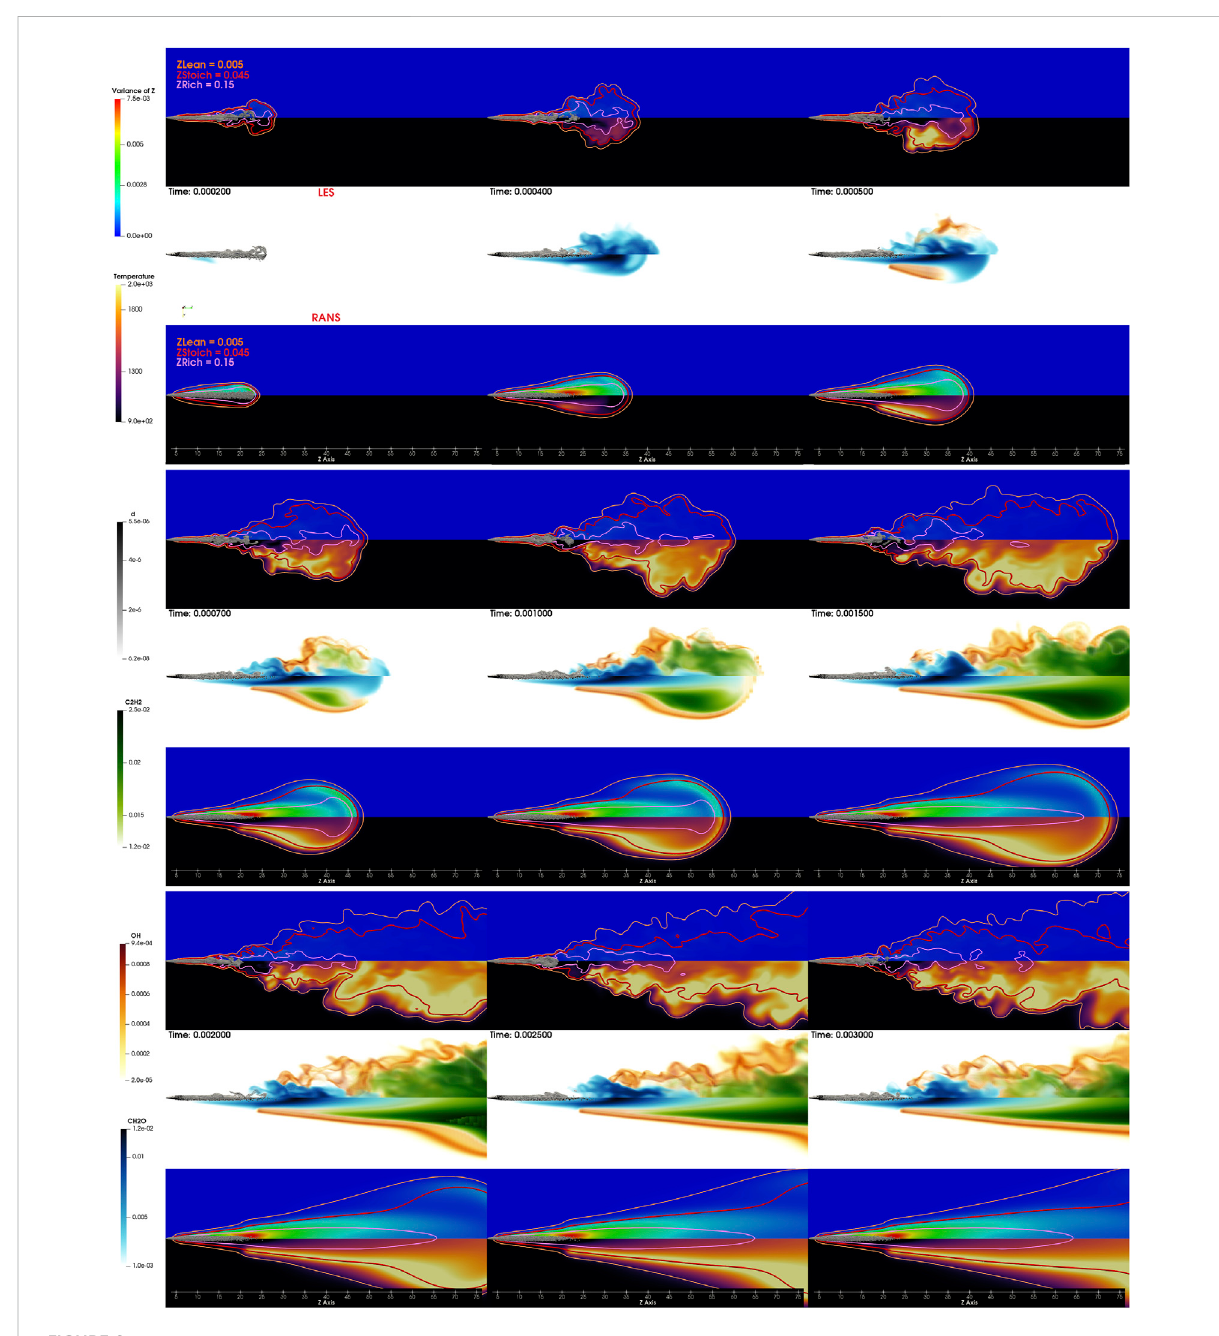
FIGURE 9 Spray D fl ame evolution from 0.2 ms to 3 ms. The image is divided into three parts: from 0.2 to 0.5 ms, from 0.7 to 1.5 ms, and from 2 to 3 ms. Each part is further divided into three: the central image represents OH, CH 2 O, and C 2 H 2 for the LES (upper) and RANS (lower) frameworks. The surrounding images are the temperature distribution, the variance of the mixture fraction, and three contours of the mixture fraction (lean, stoichiometric, and